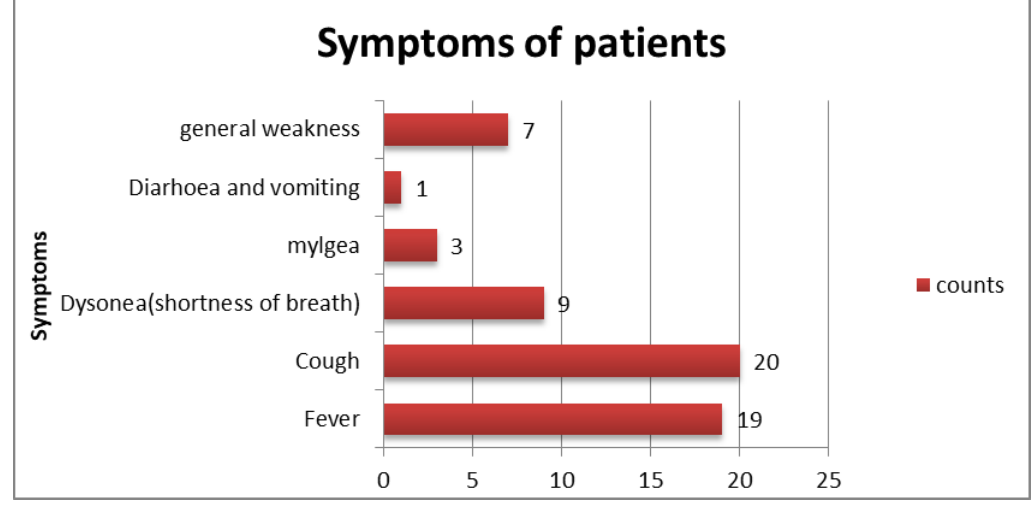
Figure 1: presenting symptoms among patients The eight asymptomatic patients represented (22.86%) from all patients, other symptomatic patients were distributed to the following: Near half of the patients (51.43%) were with mild diseases, five patients(14.29%) moderate while only one patient (2.86%) with severe symptoms and (8.57%) were critical cases according to CDC China criteria. Two out of three critical cases passed away while all other patients were recovered and discharged from the